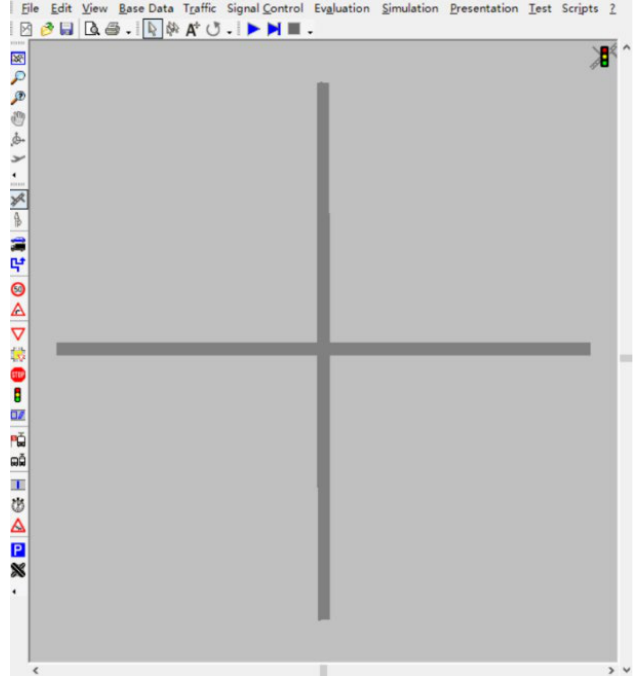
Figure 3. VISSIM simulation road network. VISSIM simulation parameters. CAV: connected and automated vehicle, HV: human-driven